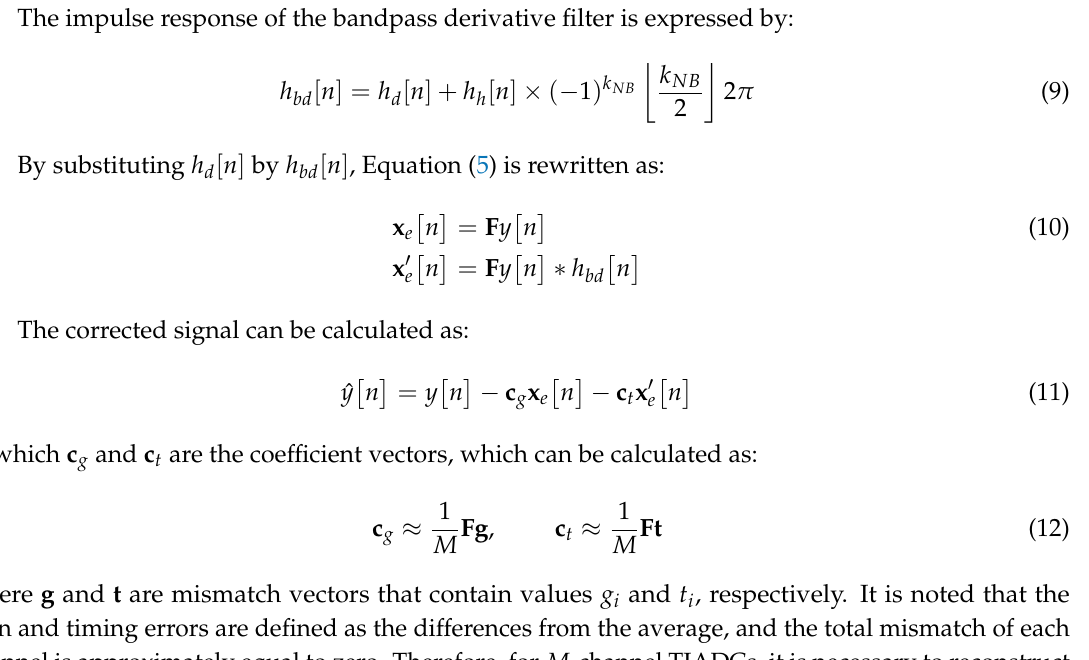
Figure 4. Bandpass derivative filter for the proposed calibration technique. FIR, finite impulse